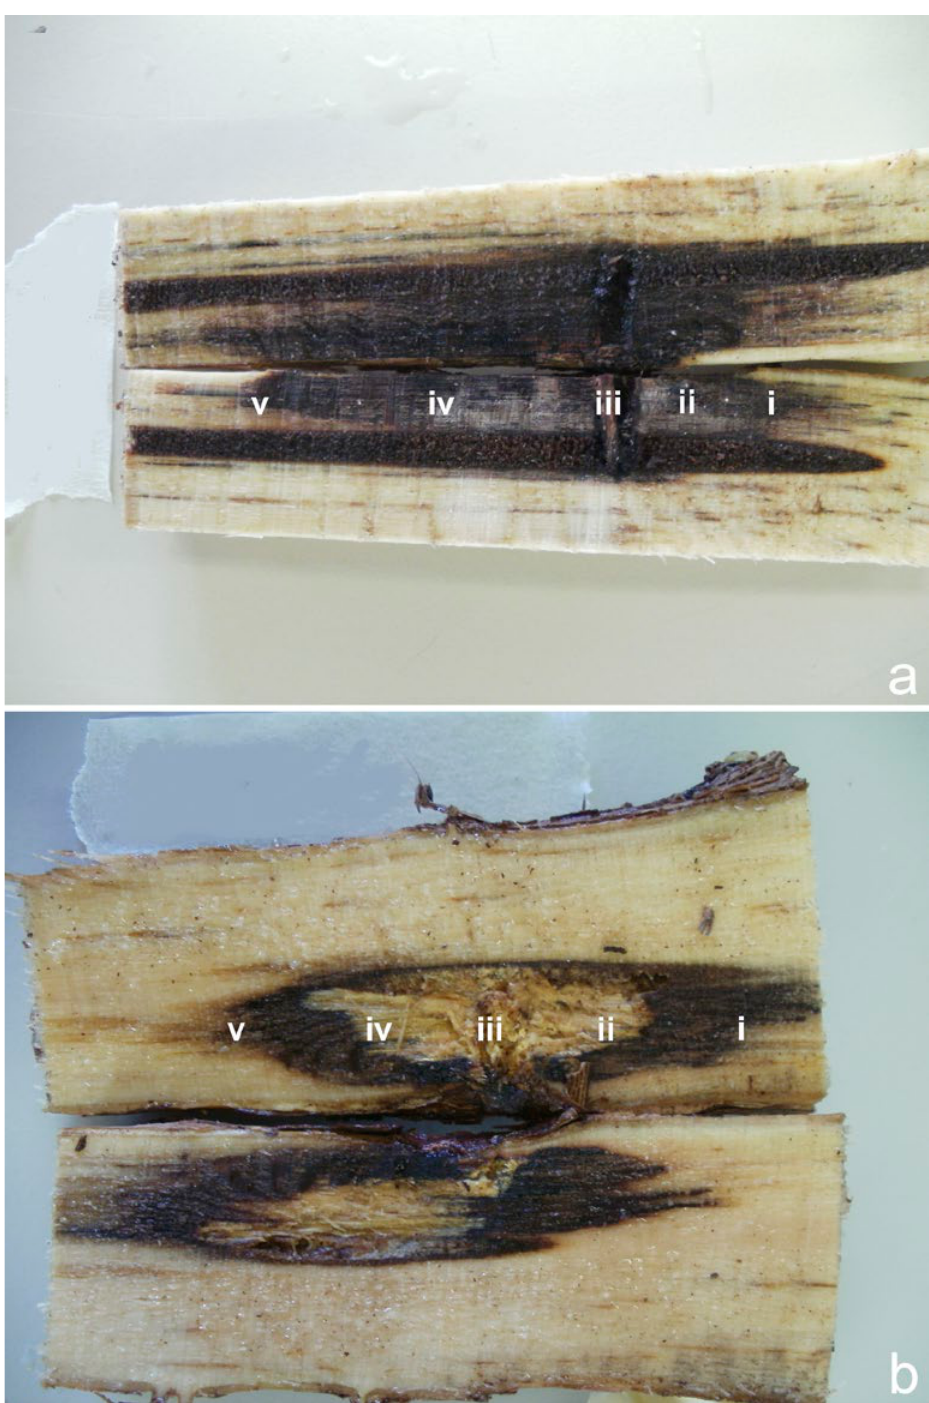
Figure 2. Isolation sites on Hymenochaetales inoculated grapevine samples. a. A discoloured lesion without rot on Shiraz. i. Isolation site on the proximal end of the lesion. ii. Isolation site in the middle of the lesion. iii. Isolation at wound site. iv. Isolation site in the middle of the lesion. v. Isolation site on the distal end of the lesion. b. A discoloured lesion with white rot on Mourvédre, i-v the same as on